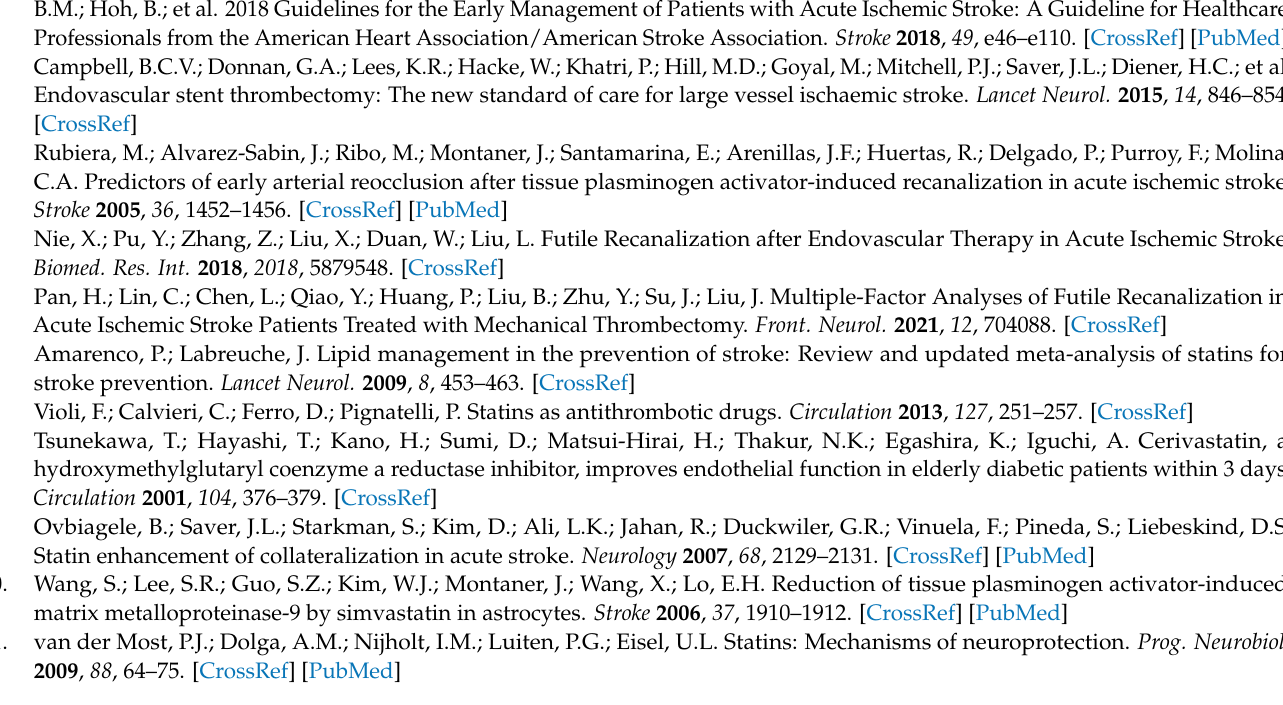
reperfusion therapy, Table S3: Multivariate analysis showing the effect of prior statin use on stroke outcomes, Table S4: Descriptive Statistics using Propensity Score